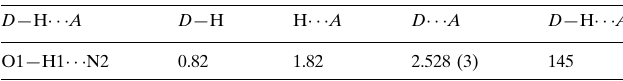
Hydrogen-bond geometry (A˚ , (cid:2)